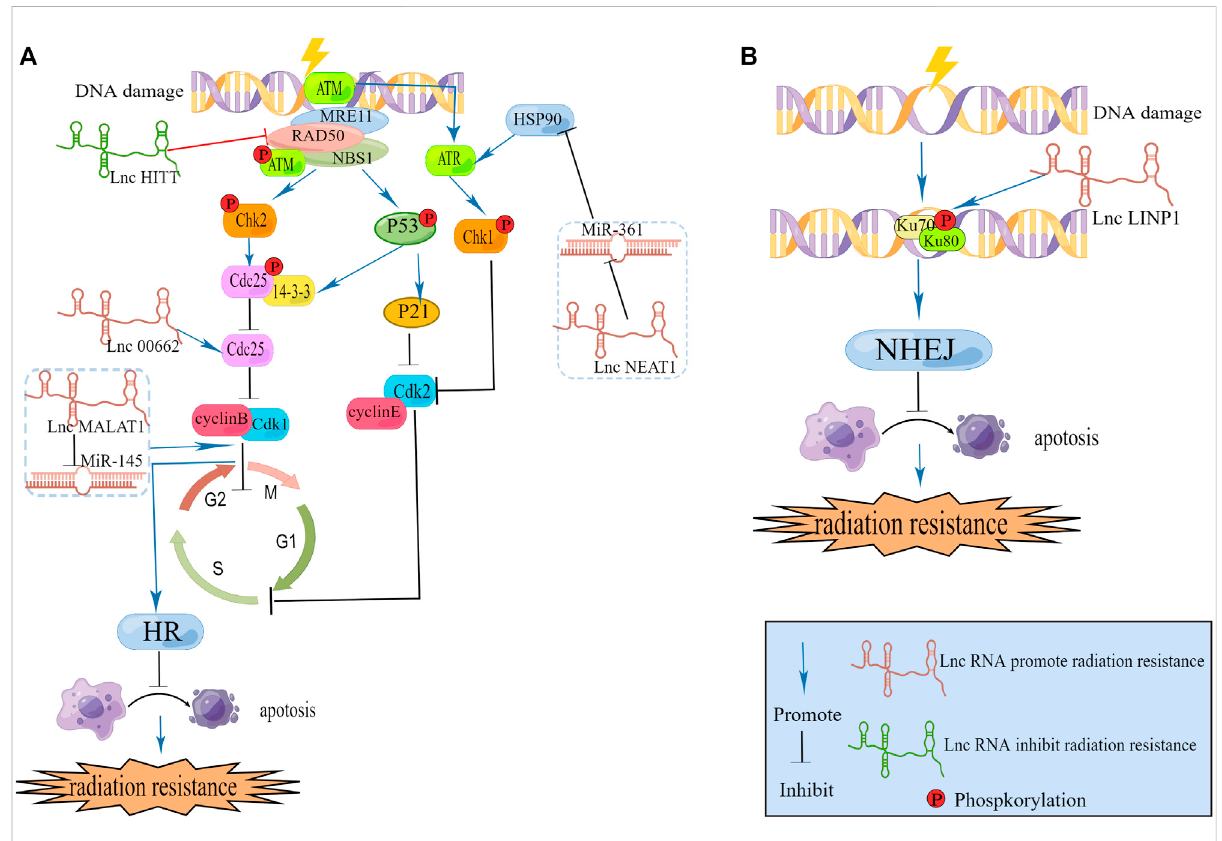
FIGURE 2 (A) LncRNAs modulate DNA damage repair caused by HR and cell cycle. (B) LncRNA modulate DNA damage repair caused by